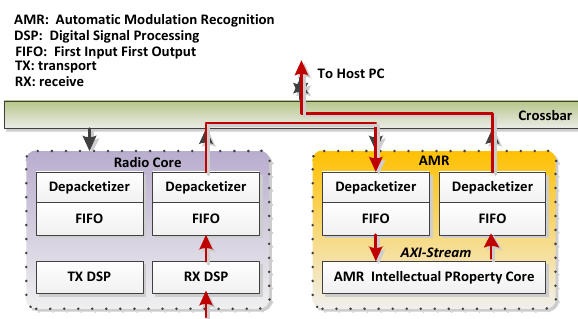
Figure 5. Data flow of our radiofrequency network-on-chip (RFNoC)-based modulation recognition application.